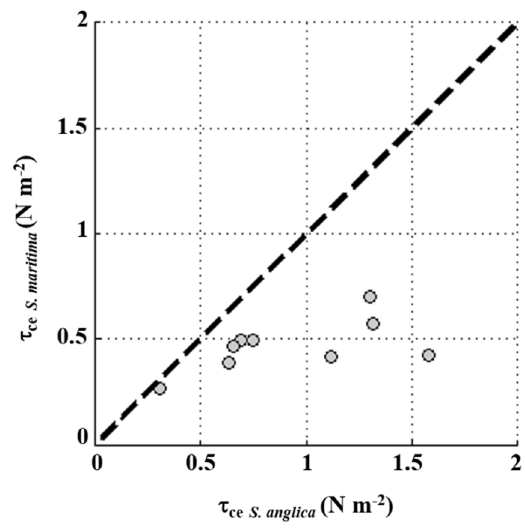
Figure 3. Critical bottom shear stress for erosion ( τ ce —N m − 2 ) within Spartina anglica versus Spartina maritima ( p < 0.002 with significance threshold at p =